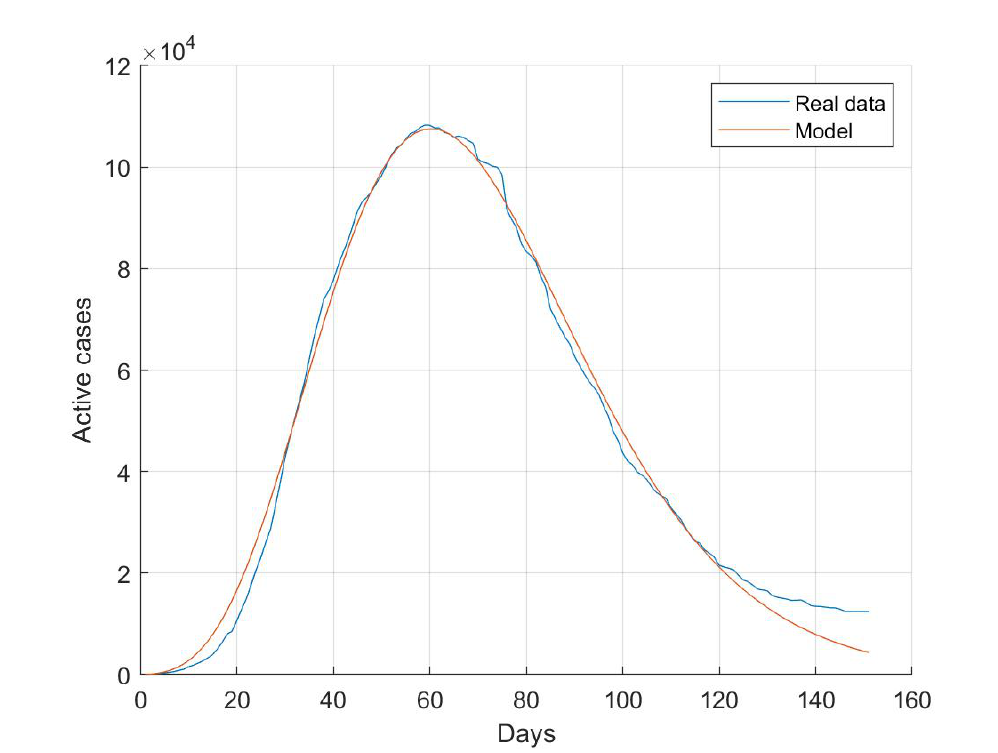
Figure 4. Modeled vs. actual disease transmission in Italy.